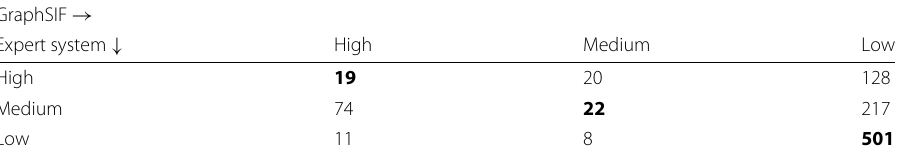
Table 5 Confusion Matrix - SiS Rule Engine’s and